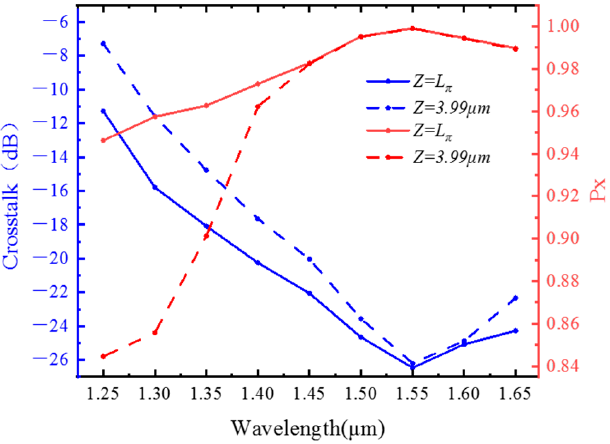
Figure 10. Variations of the crosstalk and conversion ratio at Z = L π and Z = 3.99 μ m with wave- length.